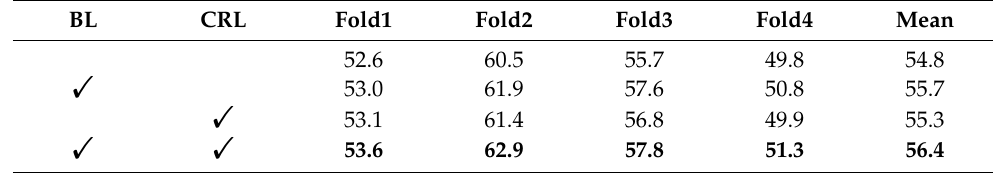
Table 6. Ablation studies on the effects of different components. Contrastive Representation